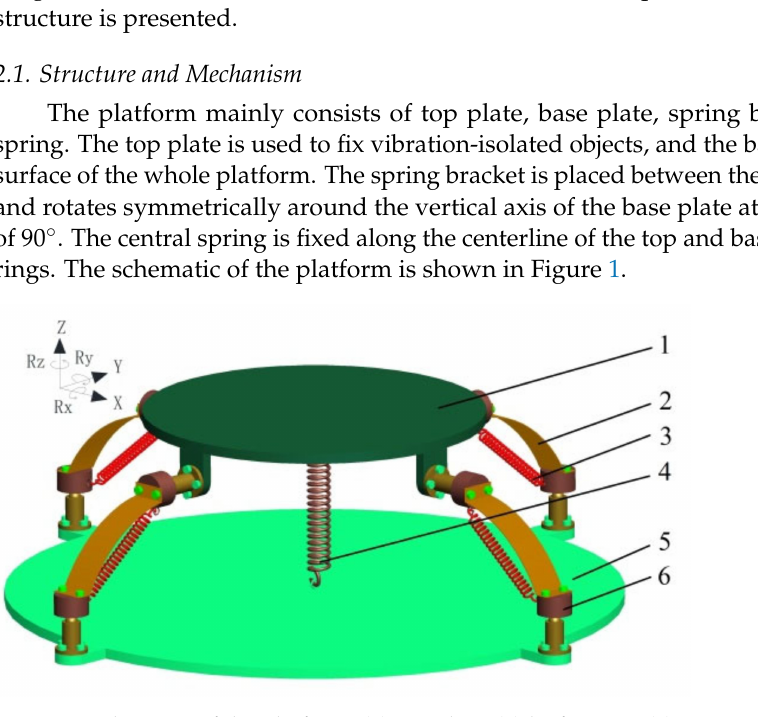
Figure 1. Schematic of the platform: (1) top plate; (2) leaf spring; (3) suspension spring; (4) central spring; (5) base plate; (6) spherical